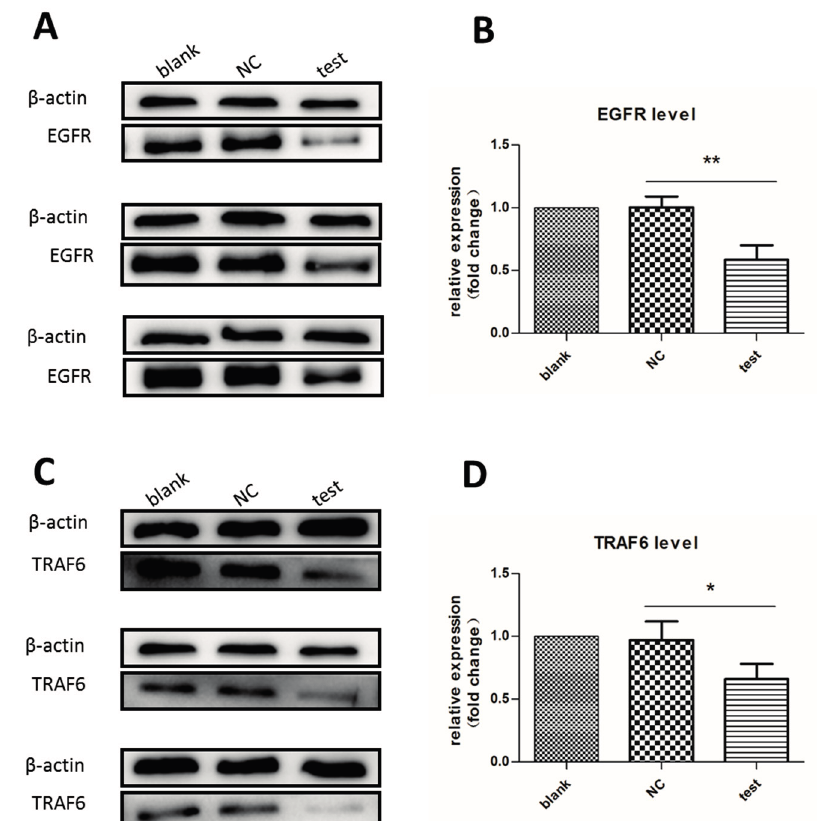
Figure 2. Western blot analysis of EGFR and TRAF6 expression. Cells were stimulated with RANKL/M-CSF for three days and treated with 500 nM MS2-miR-146a VLPs (test group) or 500 nM MS2-miRNC VLPs (negative control group (NC)). Lysates were cleared of cellular debris, and equal concentrations of protein (30 µg) were separated via SDS-PAGE. Proteins were identified by incubating polyvinylidene fluoride (PVDF) membrane with monoclonal antibodies. β -actin was used as a loading control. ( A , B ) Expression level of EGFR; and ( C , D ) Expression level of TRAF6. * p < 0.05, ** p < 0.01. Each experiment was carried out in